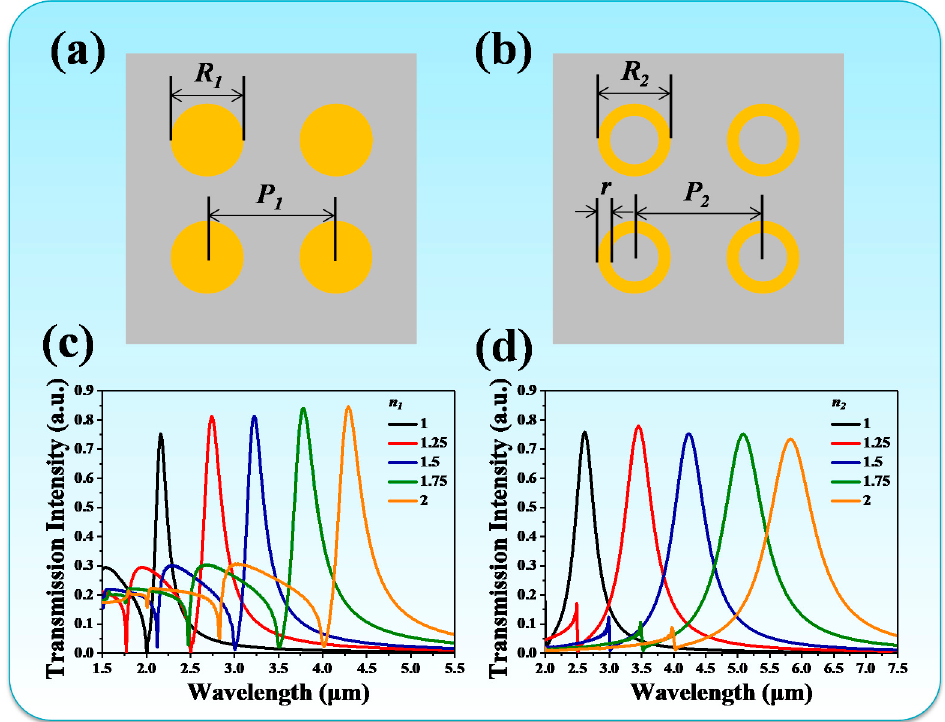
Figure 5. Schematic drawings of ( a ) circle-shaped and ( b ) ring-shaped metamaterials. Transmission spectra with different n 1 and n 2 values for ( c ) circle-shaped and ( d ) ring-shaped metamaterials. Initial geometrical dimensions were R 1 = R 2 = 1 µ m, P 1 = P 2 = 2 µ m, r = 0.2 µ m.